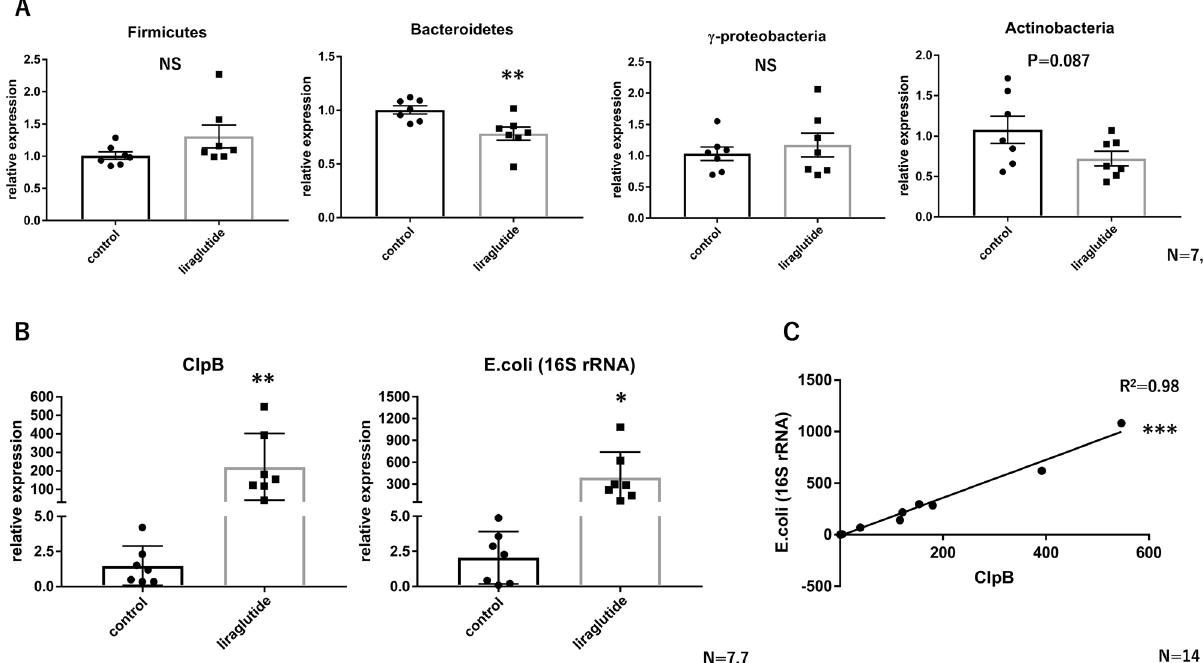
Figure 1. Acute administration of liraglutide increases E. coli levels in mice. Relative expression of ( A ) major gut microbiota (phylum level) and ( B ) ClpB and E. coli (16S rRNA) in cecal contents with or without acute liraglutide administration (control, n = 7; liraglutide, n = 7). ( C ) Correlation between the relative expression of ClpB and E. coli (16S rRNA) in cecal contents (n = 14). All values represent the mean ± SEM. * P < 0.05, ** P < 0.01, *** P < 0.001; NS, not significant by non-paired t-test ( A and B ) or linear regression analysis ( C ). The coefficient of determination is denoted as R 2 . All figures were drawn using GraphPad Prism 7 (www. graph pad. com) and Microsoft’s PowerPoint 2016 (www. micro soft.